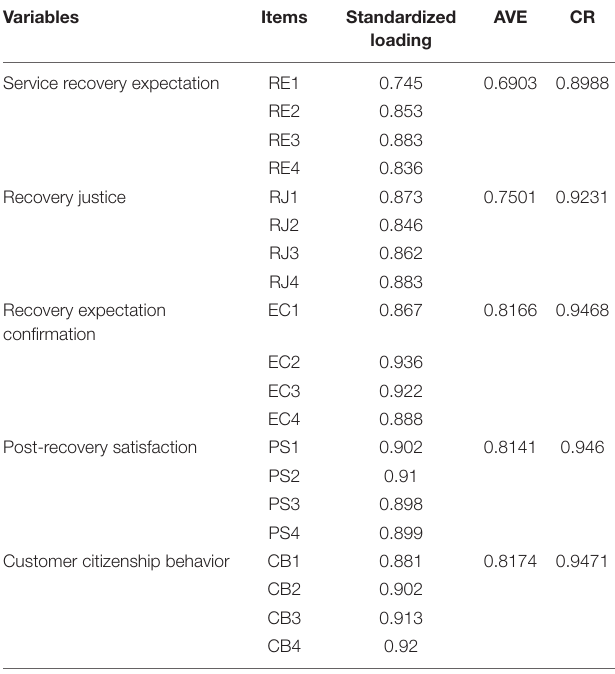
TABLE 2 | Results of measurement